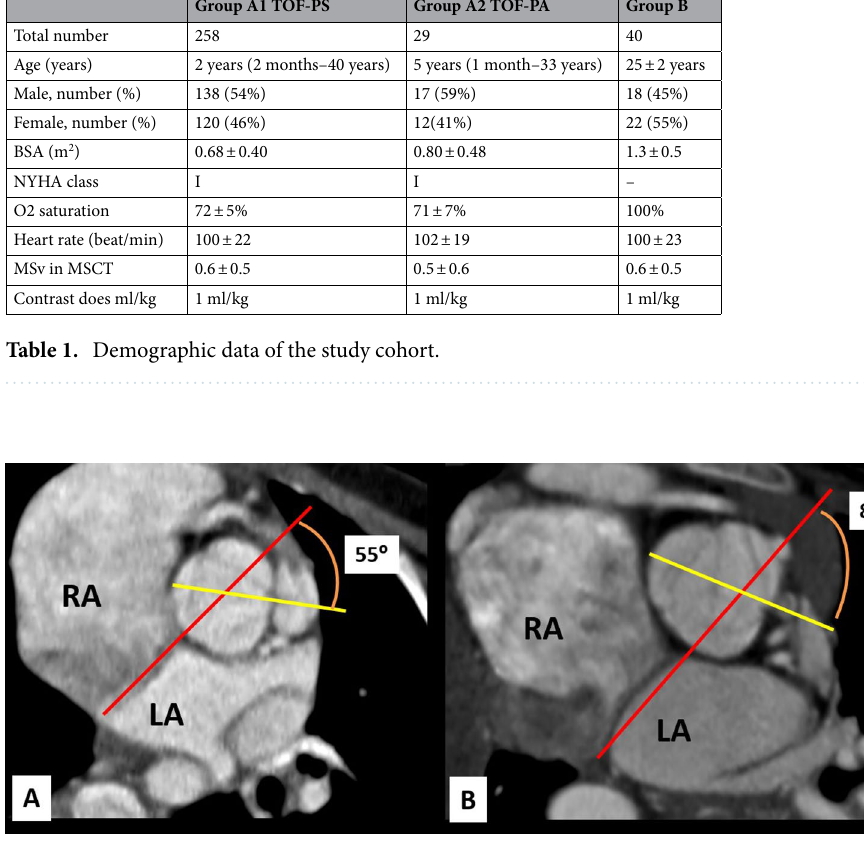
Figure 4. Measurement of aortic root rotation angle in TOF patients. ( A ) A case of TOF-PS with a clockwise rotation angle of the aortic root is 55°. ( B ) A case of TOF-PA with the extreme clockwise rotation angle of the aortic root is